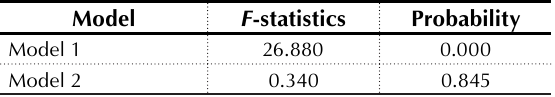
Table 6. Restricted F -test of heterogeneity